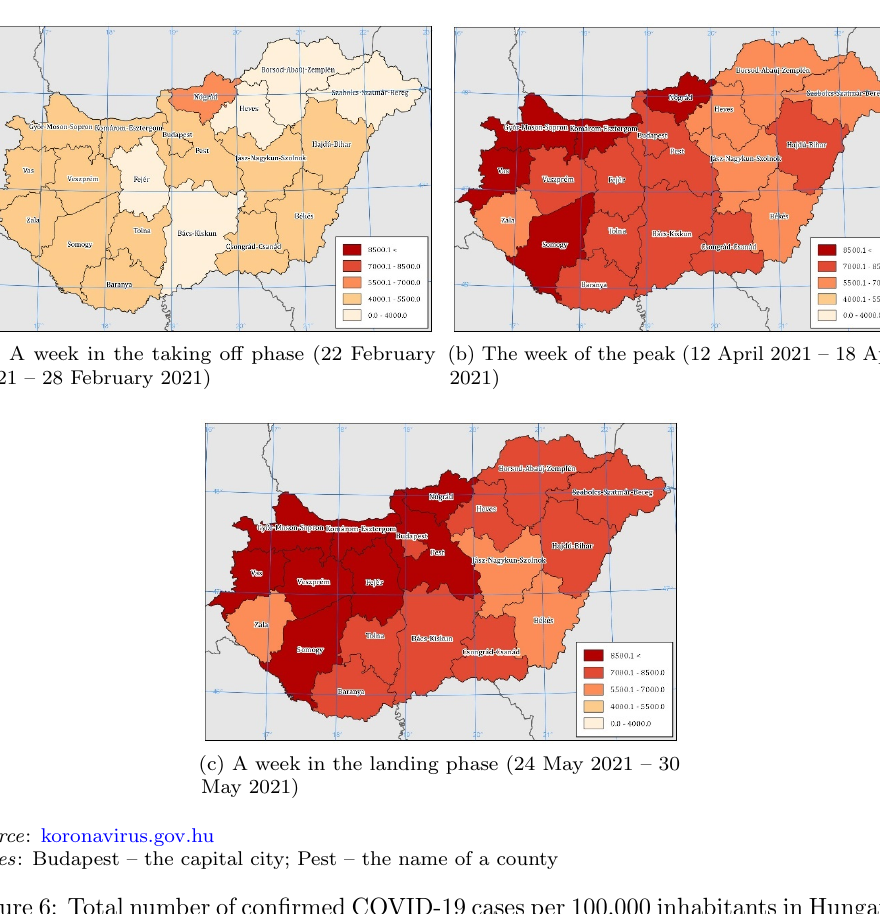
Figure 6: Total number of confirmed COVID-19 cases per 100,000 inhabitants in Hungarian counties (NUTS 3) during the different phases of the third wave, based on weeks concentration of infected people was at moderate or low levels. However, there are some less developed regions (mostly in the southern and eastern parts of Hungary) in which the concentration levels of deaths and infected people were relatively low. This can be explained by the lower risk of serious infection due to social distancing. The concentration levels in the county seats and Budapest varied between moderate and low. The